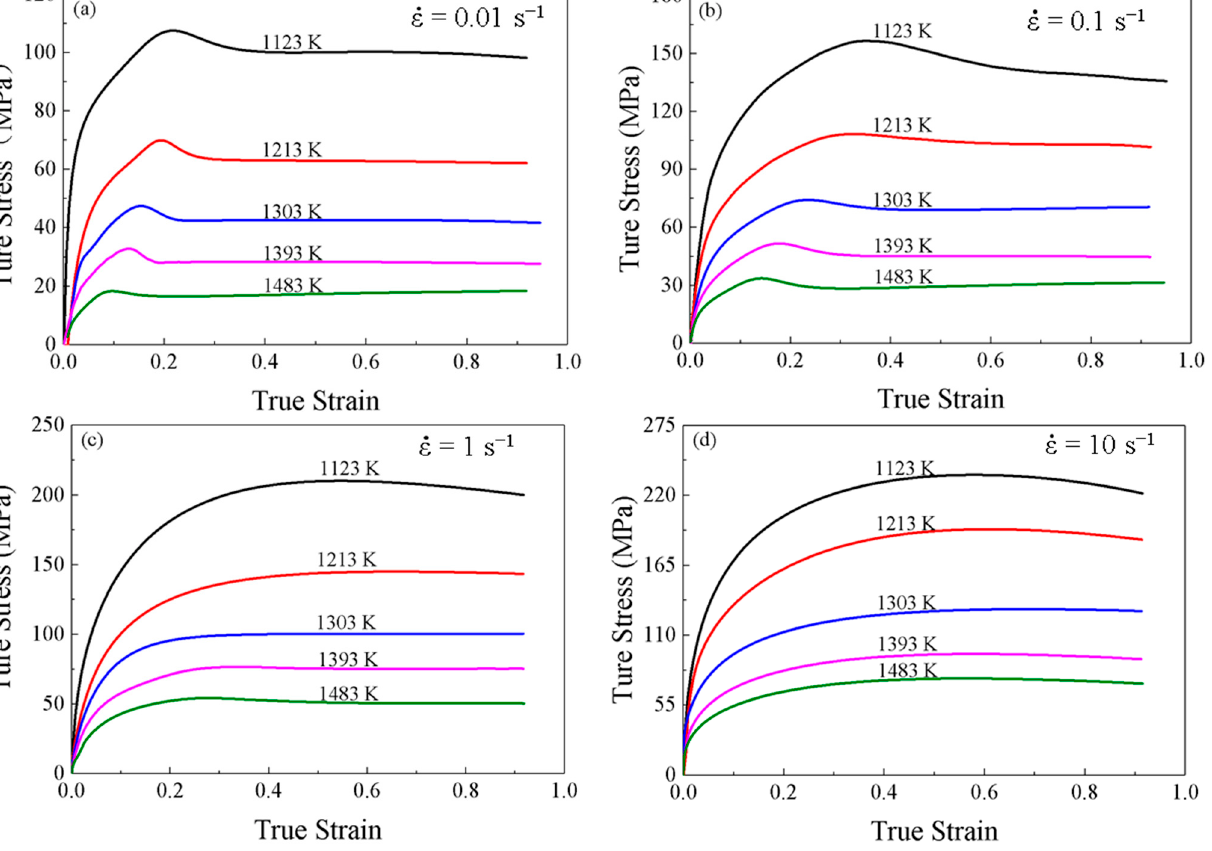
where B is expansion coe ffi cient, L 0 and L f are the original height of the specimen and the height after compression deformation, respectively, d 0 and d f are the original diameter of the specimen and the diameter after compression deformation, respectively.